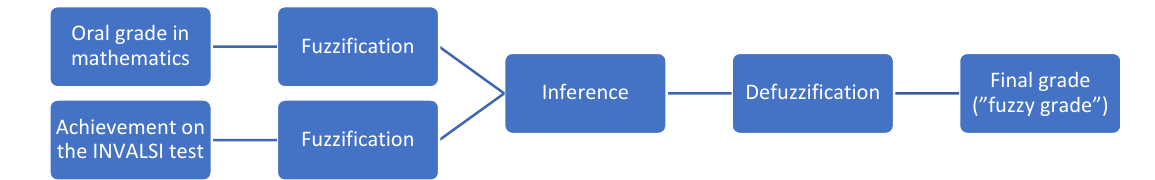
Figure 2. The use of fuzzy logic to produce the fuzzy grade.